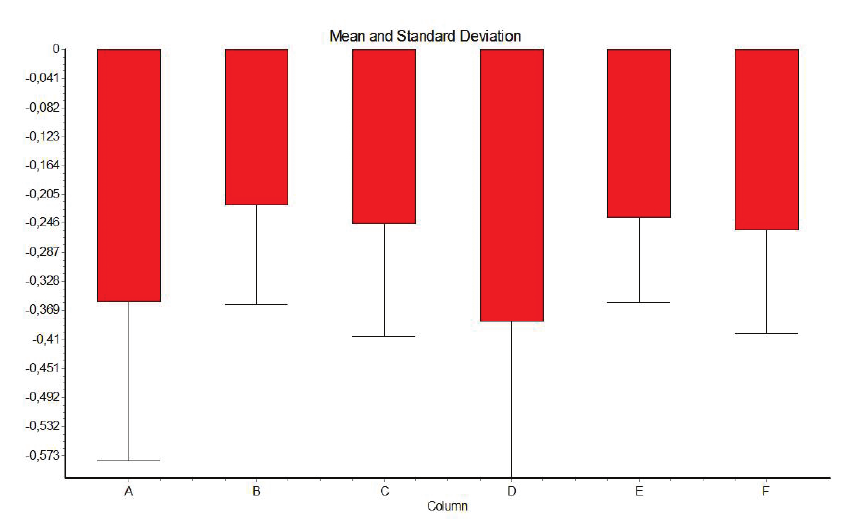
Figure 3. Mean and standard deviation values of Slope Coefficient of Median Frequency (SCMF) for the muscles: A - multifidus (RMT), B - lumbar longissimus (RLG) and C - iliocostalis (RIC) at the right side; and multifidus (LMT), lumbar longissimus (LLG), F-iliocostalis (LIC) on the left side (L), of the three sampling times of 20 volunteers, obtained during the Biering-Sorensen